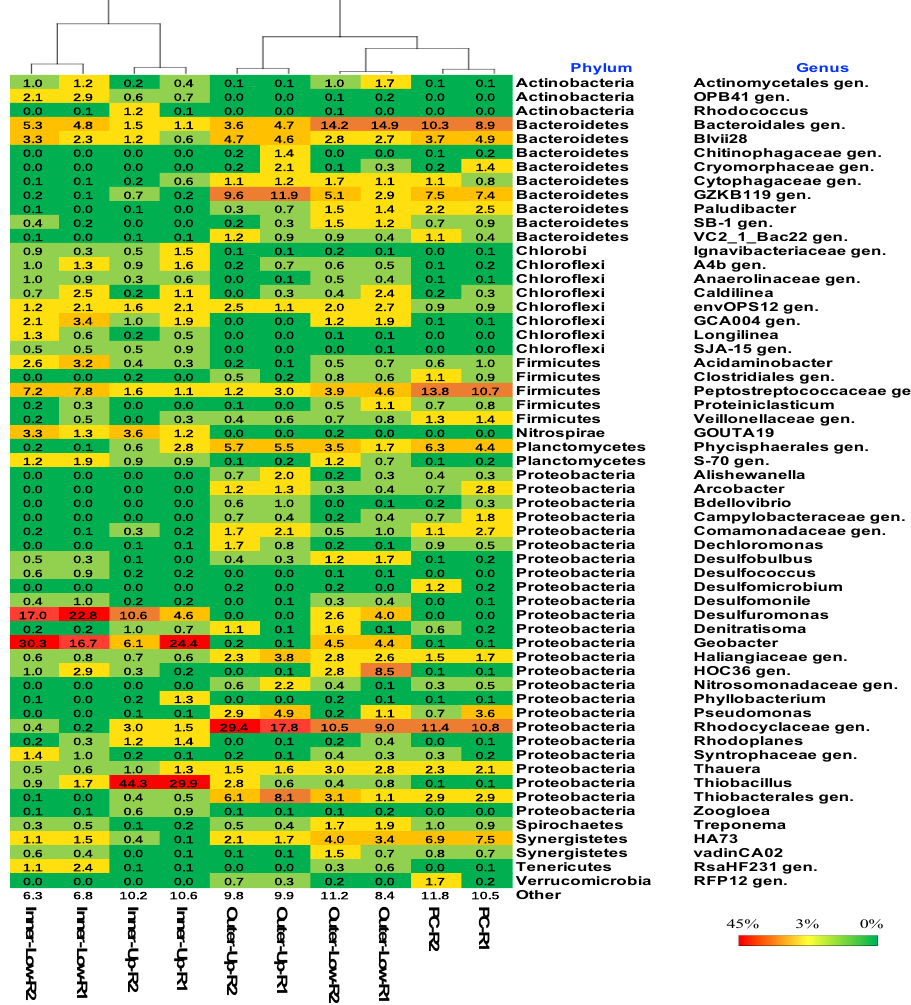
Figure 5. Phylogenetically clustered heat map of the representative genera (with abundances > 0.9%) found in the anodic biofilm communities in the bioelectrochemical system-trickling filter (BES-TF) reactors R1 and R2. PC: planktonic cells, Outer-Low: Outer biofilm of the lower part of the anode (submerged in wastewater), Outer-Up: Outer biofilm of the upper part of the anode (not submerged in the wastewater), Inner-Low: Inner biofilm of the lower part of the anode (submerged in wastewater), Inner-Up: Inner biofilm of the upper part of the anode (not submerged in the wastewater).